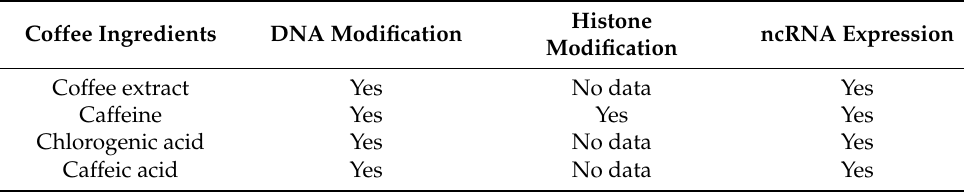
Table 1. An overview of the epigenetic effects of coffee